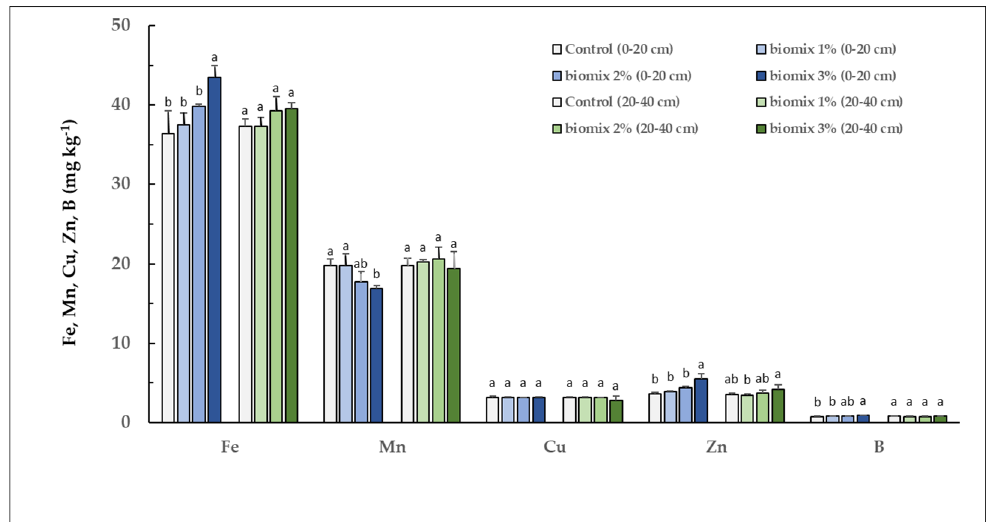
Figure 8. Average B (mg kg − 1 ), Fe (mg kg − 1 ), Mn (mg kg − 1 ), Zn (mg kg − 1 ) and Cu (mg kg − 1 ) concentrations and their standard deviations (SD) of samples of the four treatments (a) at 0 − 20 cm depth and (b) at 20 − 40 cm depth. Each value is the mean of three replicates. Different letters above each column within the same parameter evaluated, indicate significant differences.